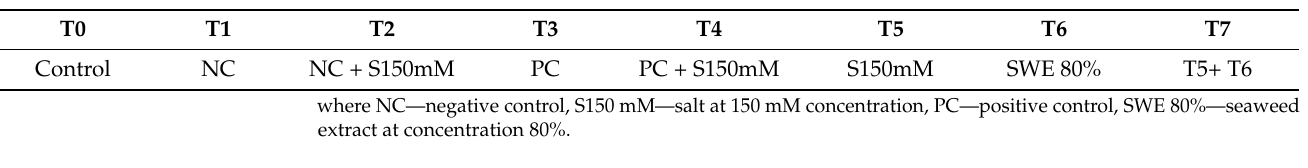
Table 1. Treatment solutions used in the